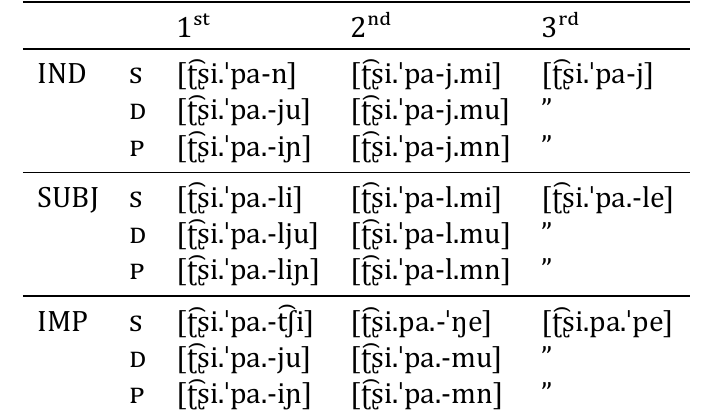
Although Valdivia does not deal with the issue of consonant-(cid:976)inal versus vowel-(cid:976)inal roots, the data he provides in the Vocabulary and Con- fessionary that close his grammar, and his Sermons (Valdivia 1621), point to a series of verbs with epenthetic ⟨ i ⟩ breaking up consonantal clusters at the root/in(cid:976)lection boundary, as in